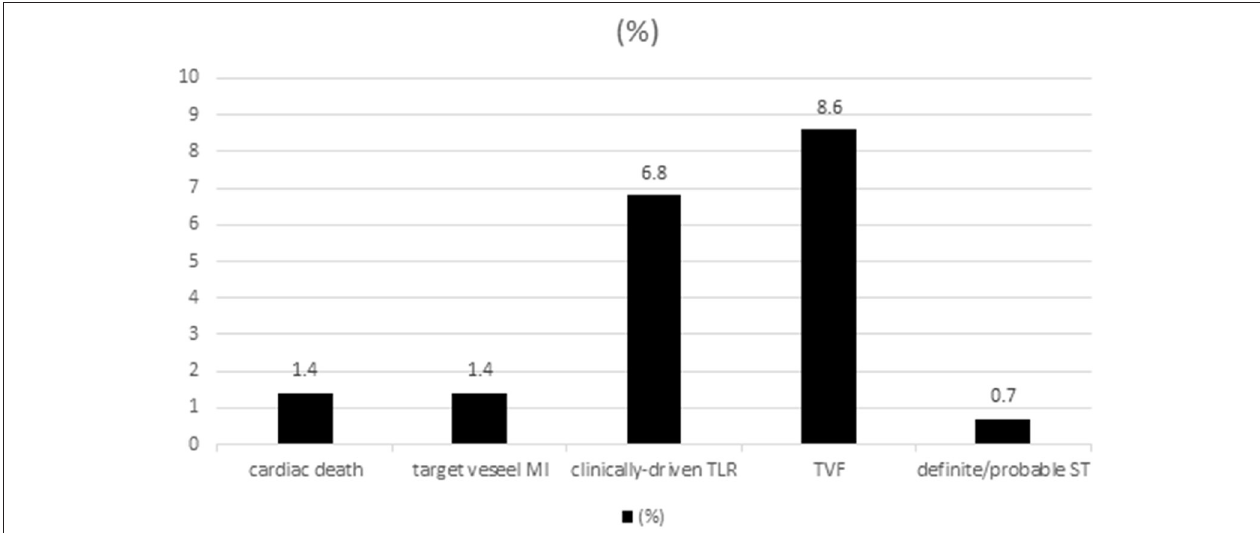
FIGURE 3 | Long-term outcomes of the 278 patients with successful chronic total occlusion- percutaneous coronary intervention (CTO-PCI) by pure antegrade wiring techniques.